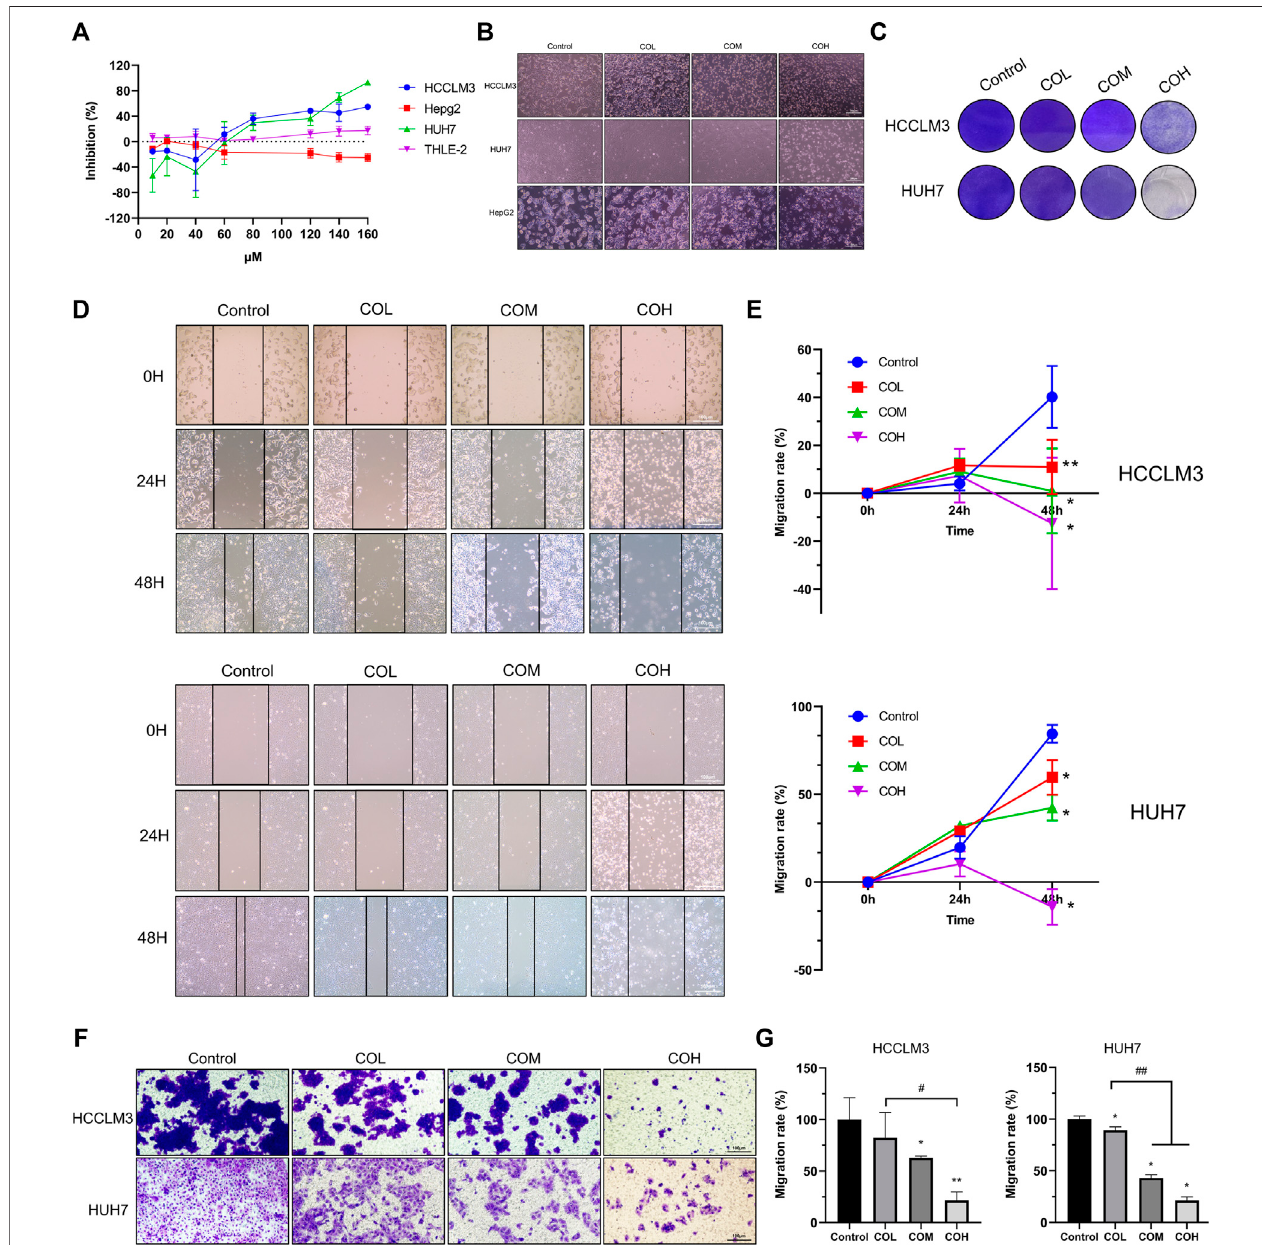
FIGURE1| InhibitoryeffectofcaryophylleneoxideonHCCLM3andHUH7cells. (A) TheCCK8assaywasusedtodeterminecaryophylleneoxide ’ sinhibitioneffect ontheinhibition ofTHLE-2,HepG2,HCCLM3,andHUH7cellsafter 48 h. (B) Themorphologicalchangesinhepatomacellsincubated withcaryophylleneoxidefor48 h wereobservedunderlightmicroscope. (C) Crystalvioletstainingrevealedtheinhibitioneffectofcaryophyllene oxideonHCCLM3andHUH7cells. (D) , (E) Theeffectsof caryophyllene oxide on the migration of HCCLM3 and HUH7 cells were investigated using the cell scratch test and the trans-well experiment, and the results were presentedasmobility (F) , (G) .Thedatawerepresentedasmean±SD.* p < 0.05,** p < 0.01whencomparedtothecontrolgroup. # p < 0.05, ## p < 0.01whencompared to the COL